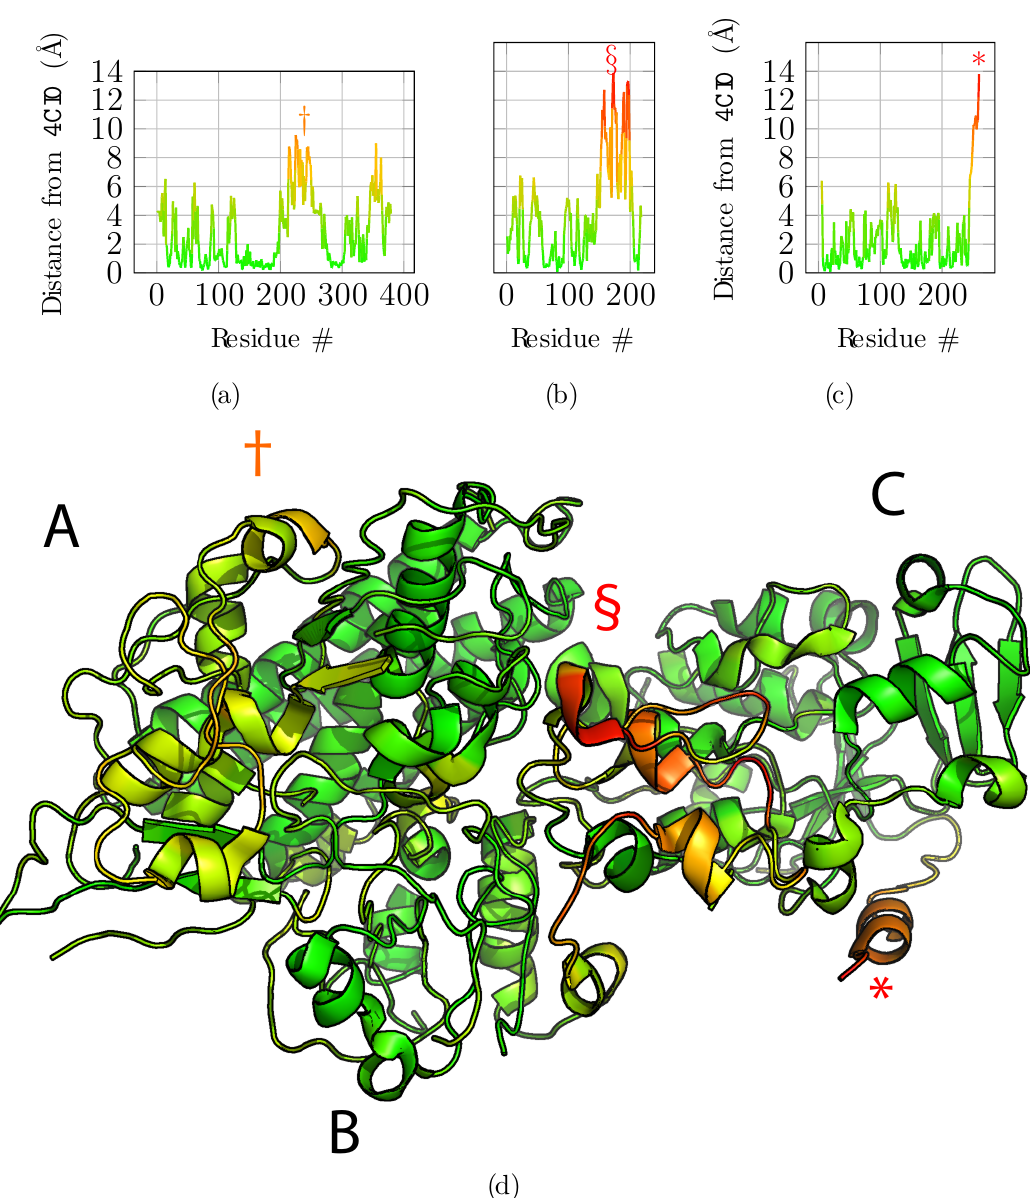
Figure 5. Structural alignment and comparison with the reference structure 4CI0 . ( a – c ) Deviations of the final model for each of the C α atoms from the 4CI0 structure aligned on the model, for chains A, B, and C, respectively. ( d ) Final model with C α deviations projected onto the structure using the same color map as for graphs ( a – c ). Symbols †, § and * highlight regions in the structure with high deviations from the reference structure for chains A, B, and C,